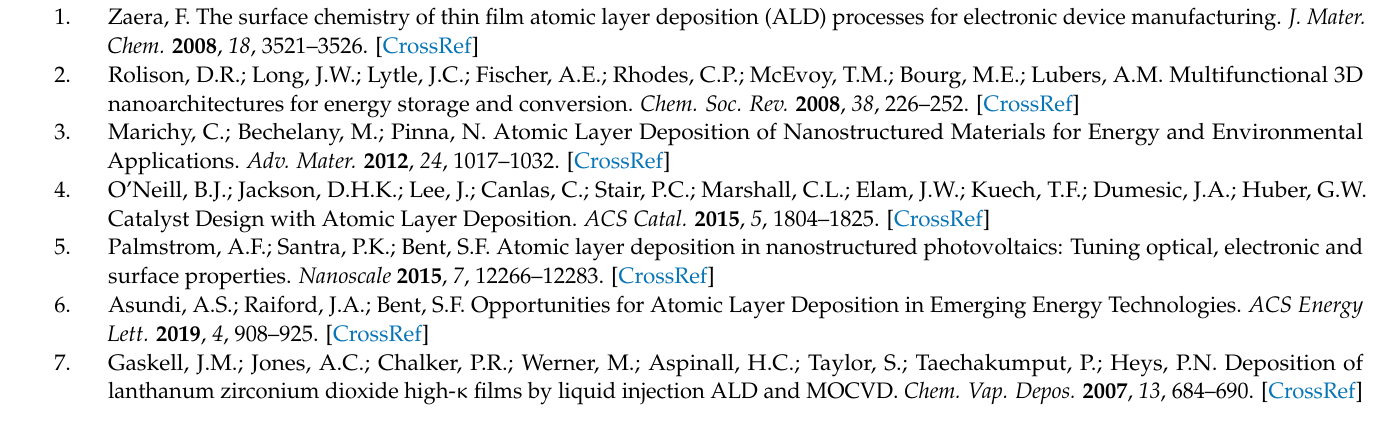
Table S4: Atomic coordinates of 5-layer ZrO2 substrate; Table S5: Atomic coordinates of 3-layer ZrO2 substrate 55